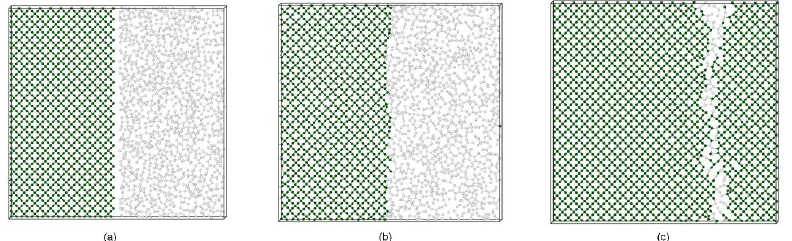
Figure 1. Section of the SiC S/L phase model in the middle position. The Miller index of S/L interface is (1 0 0). (The green atoms are solid atoms and the gray atoms are liquid atoms.) ( a ) The initial S/L phase model. ( b ) The configuration of stress-relieving. ( c ) The system is quenched to 200 K at R1 cooling rate.